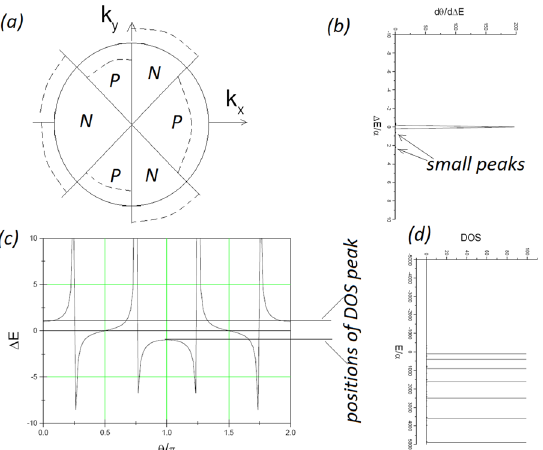
Figure 2. ( a ) Sketch illustrating energy shift varying over the 2 D Fermi circle, where P (N) represents positive (negative) energy shift. The solid circle represents “unperturbed” 2 D Fermi circle, and dashed lines represent realistic 2 D Fermi surface. ( c ) is the dependence of the energy shift (cid:31) E on θ ≡ arctan , where the definition of (cid:31) E can be referred to Eq. (83). ( b ) is an example of DOS curve, ∼ d θ d � E , associated with the θ − � E curve in ( c ). ( d ) illustrating that the superposition of DOS-curves like that in ( c ) can form DOS curve with